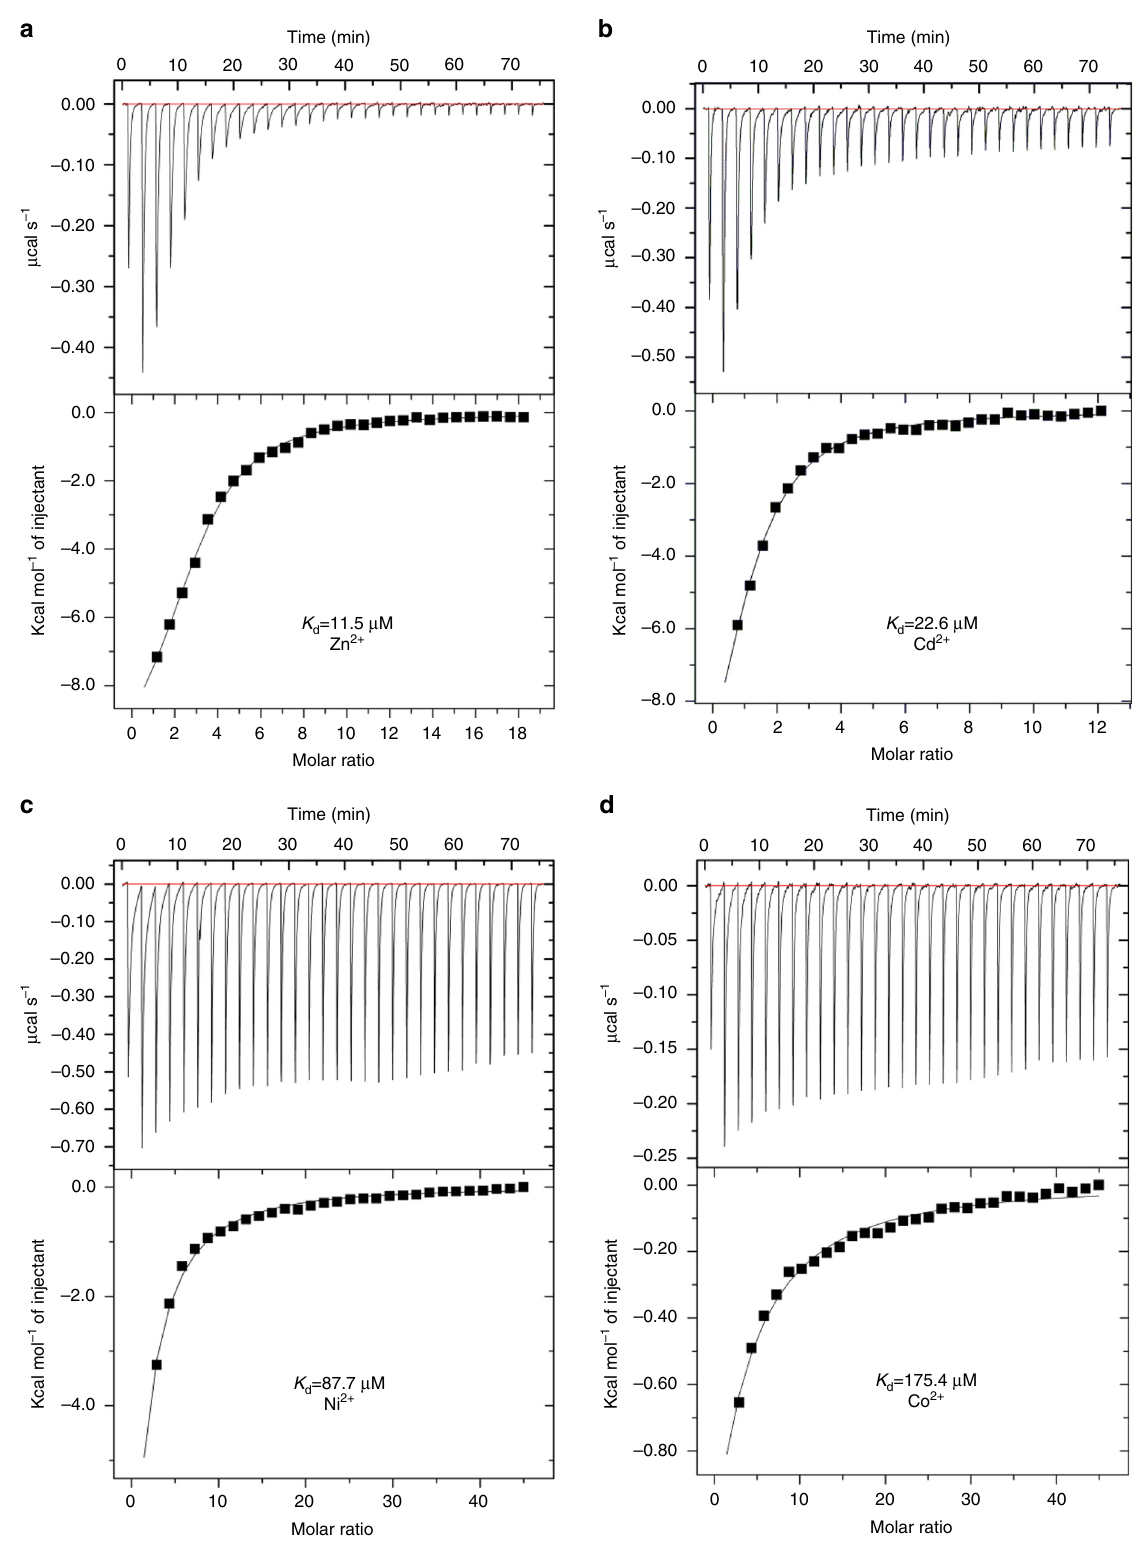
Fig. 2 ITC pro fi les of substrate binding to ZntB of ( a ) Zn 2+ ( b ) Cd 2+ ( c ) Ni 2+ ( d ) Co